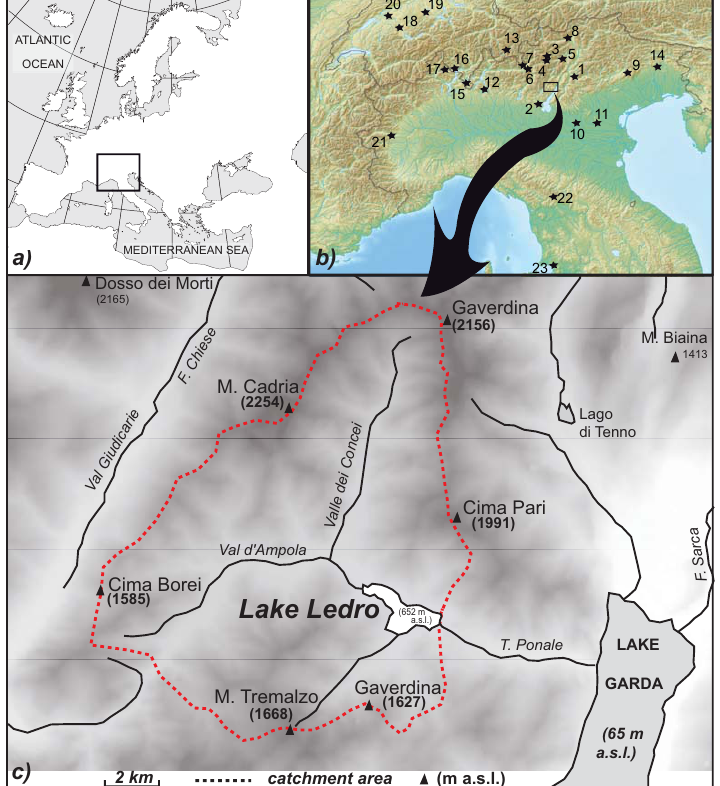
Fig. 1. (a) The study site in the northern Mediterranean area. (b) Location of pollen sites discussed in the paper for the Alps and northern Italy – 1: Lake Lavarone (Filippi et al., 2007); 2: Lake Lucone (Valsecchi et al., 2006); 3: Passo del Tonale (Gehrig, 1997); 4: Valle di